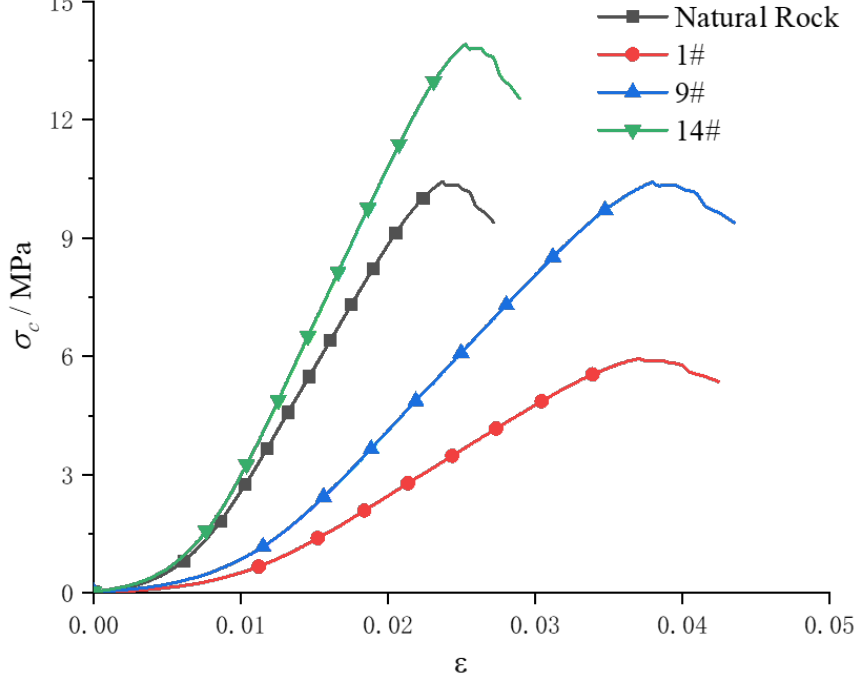
Figure 9. Stress–strain curves of similar specimens with representative disintegration processes and natural rock samples.